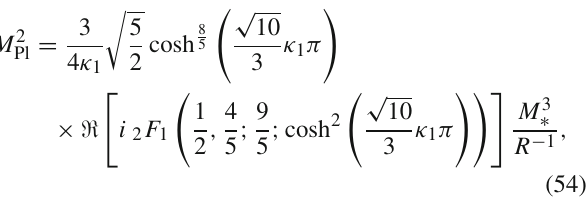
M Pl ∼ O ( 10 18 ) GeV is so much larger than the electroweak scale ∼ O ( 1 ) TeV and the inverse size of the extra dimension even they are the same scale at the fundamental